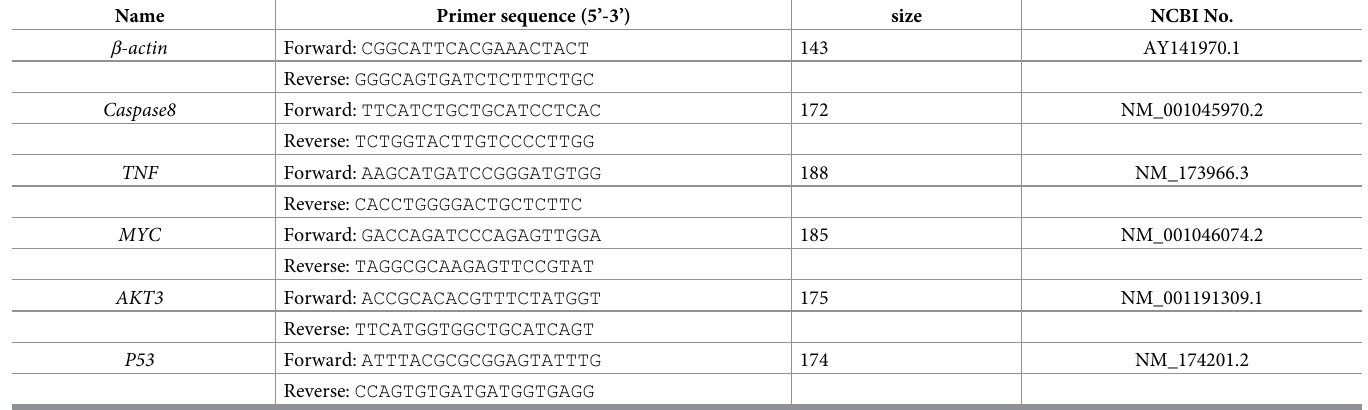
Table 1. The sequence of primers used in this